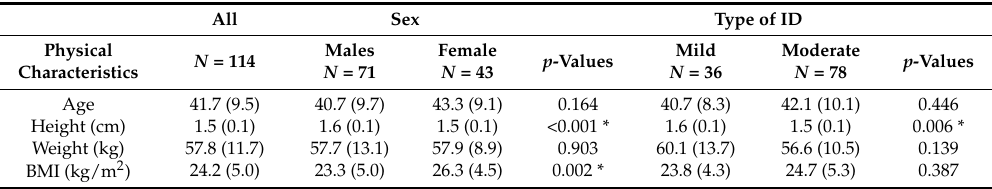
Table 1. Physical activity and physical fitness of adults with intellectual disabilities (ID) overall, and by sex and severity of intellectual